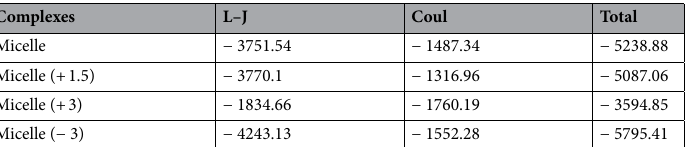
Complexes L–J Coul Total Micelle −